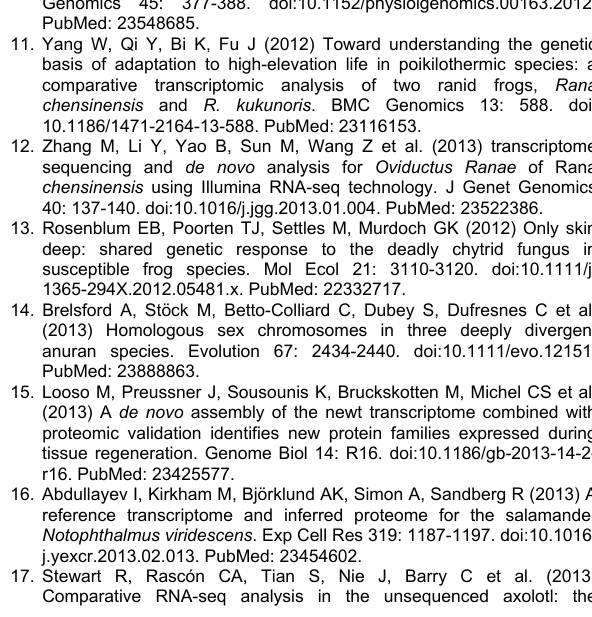
Table S1. Distribution of O. margaretae transcripts among KEGG pathways. (XLSX) Table S2. Putative AMPs in